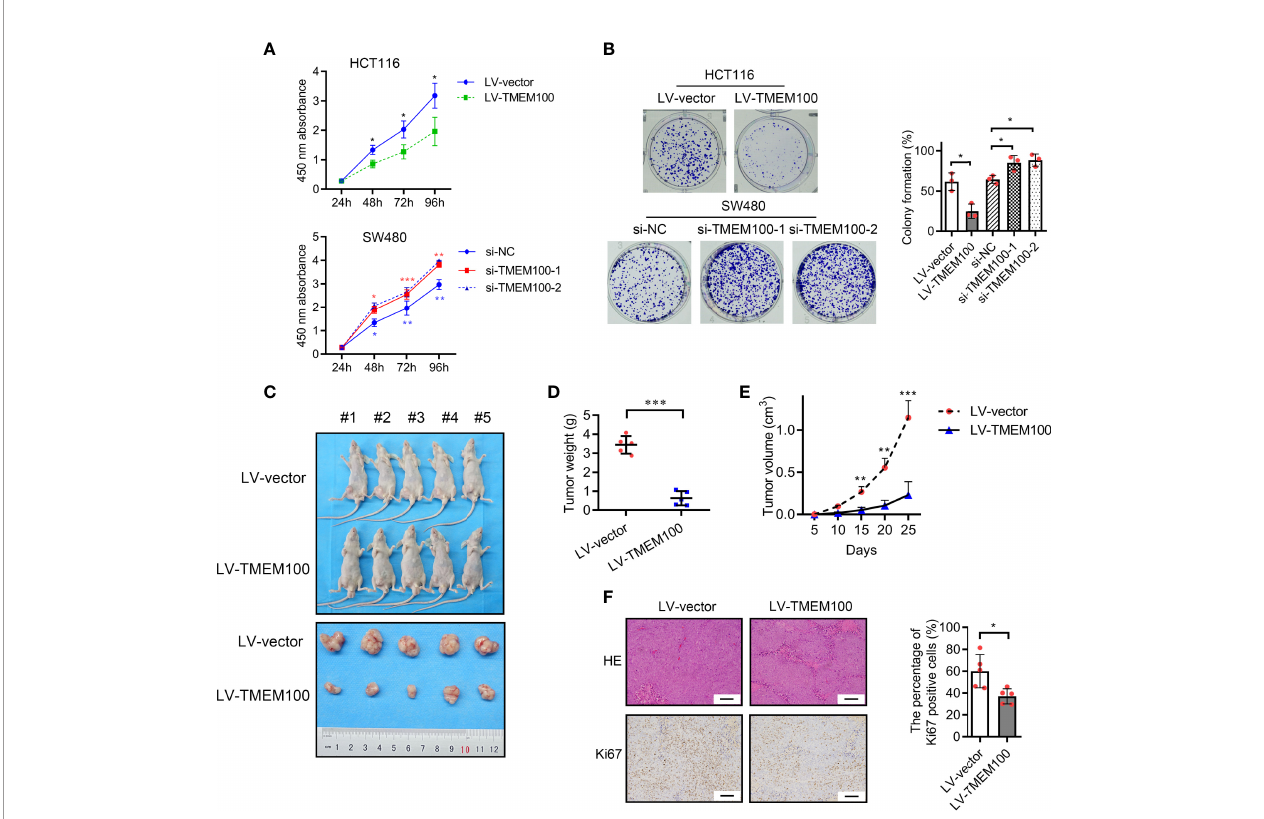
FIGURE 2 | TMEM100 inhibits proliferation of CRC cells in vitro and in vivo . (A) CCK-8 assays were used to detect the impact of TMEM100 on the proliferation rate of CRC cells. Two-sided t-test. Red asterisks represent si-NC vs. si-TMEM100-1. Blue asterisks represent si-NC vs. si-TMEM100-2. (B) Colony formation assay was used to detect the impact of TMEM100 on the colony formation capacity of CRC cells. Two-sided t-test. (C) General observation of subcutaneous tumors in nude mice (n = 5/group) were displayed. (D) The weight of subcutaneous tumors in nude mice (n = 5/group) was analyzed. Two-sided t-test. (E) The growth curve of the subcutaneous tumors (n=5/group). Two-sided t-test. (F) The representative pictures of the subcutaneous tumors stained by HE and the Ki67 expression stained by IHC (n=5/group). Scale bar = 100 m m. Two-sided t-test. All data are presented as the mean ± SD. * p <0.05, ** p <0.01, *** p